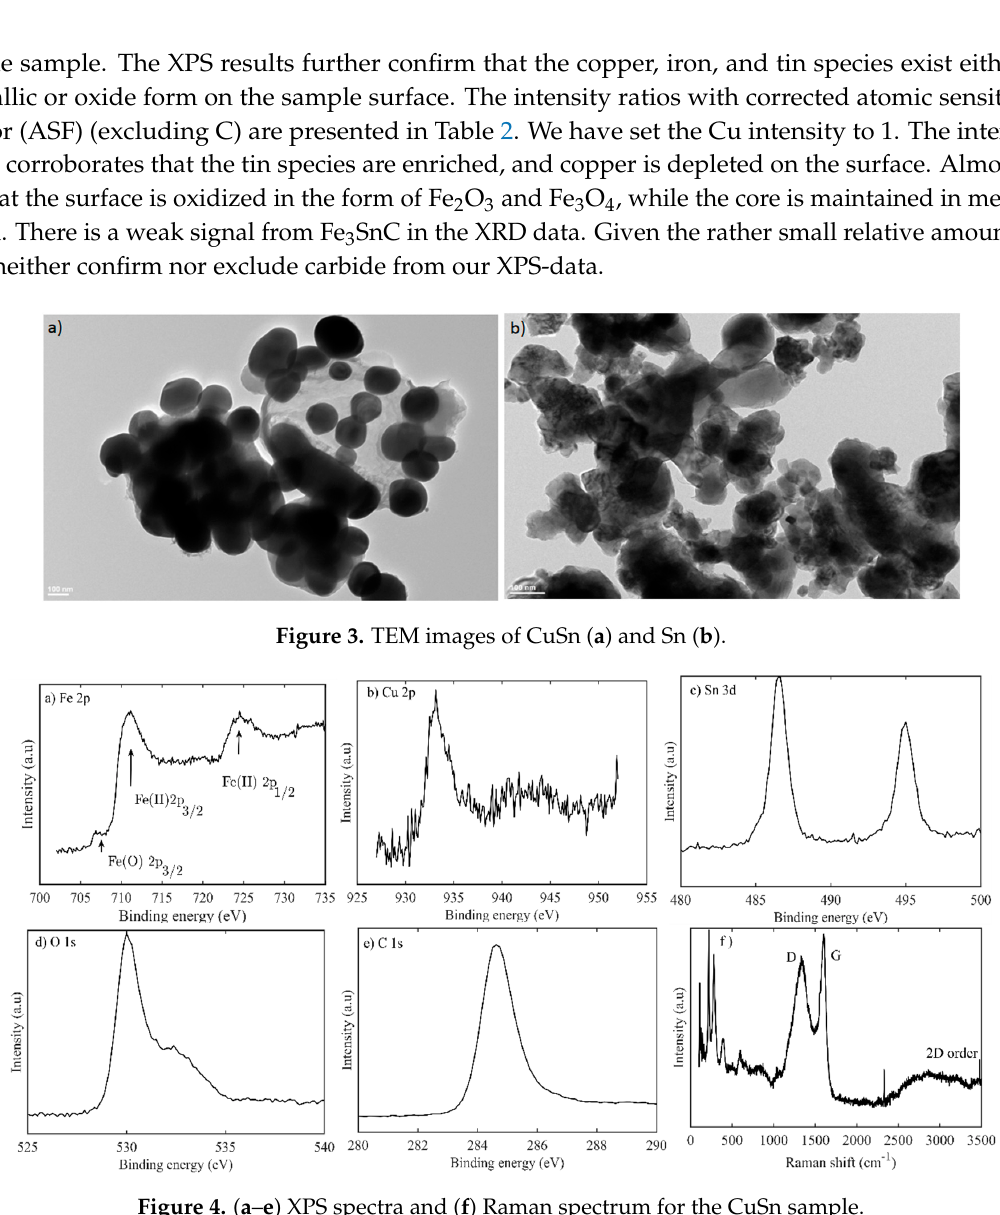
Figure 2. SEM and elemental mapping for samples of CuSn ( a – c ) and Sn ( d – f ).